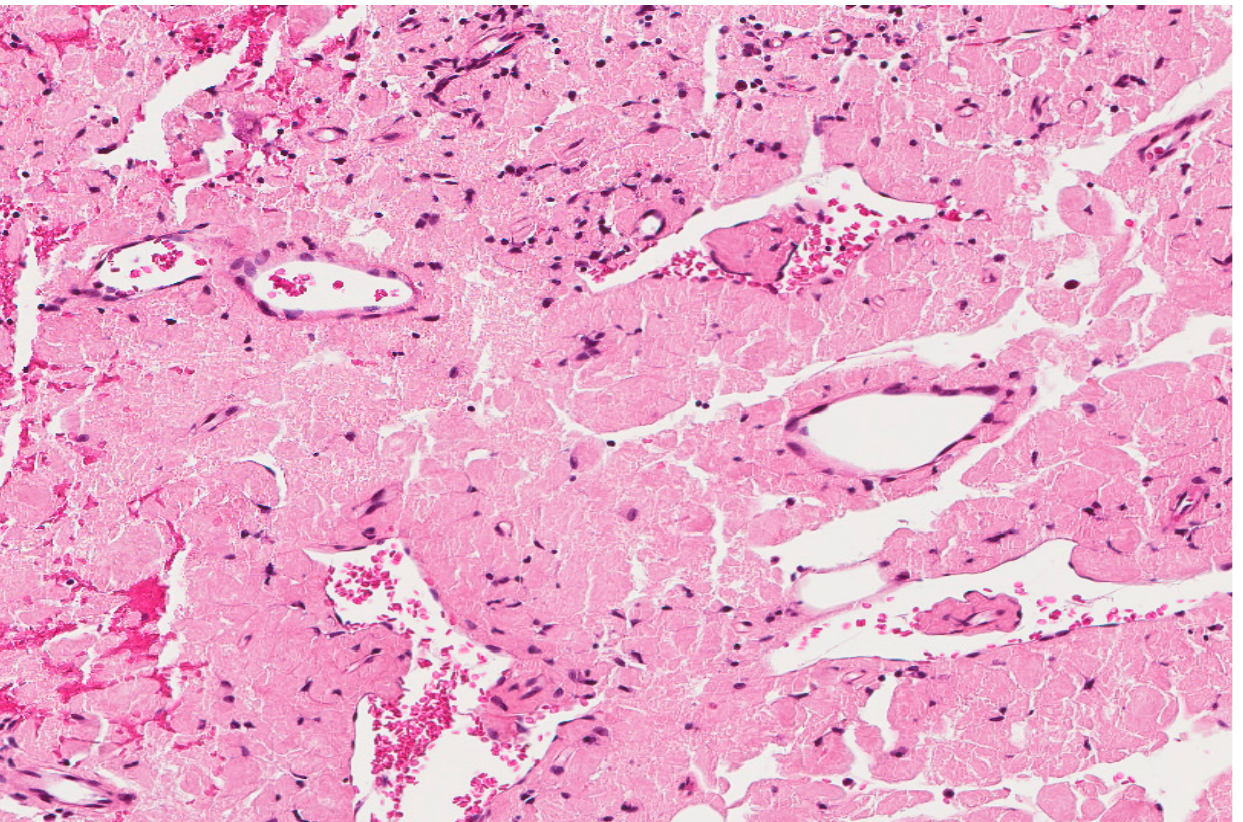
Figure 10. Amyloidosis with eosinophilic amorphous extracellular material. An 80-year-old male with a resected laryngeal polyp.